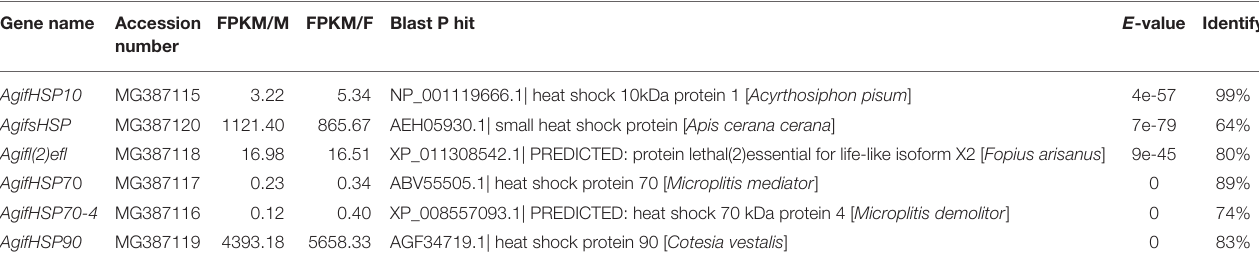
TABLE 2 | The identified heat-shock proteins in A. gifuensis .